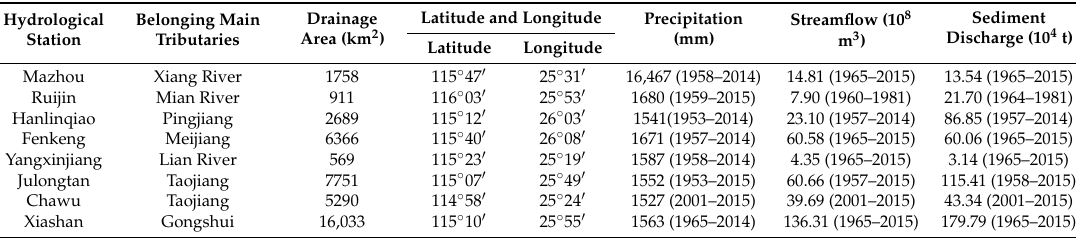
Table 1. Drainage area, average precipitation, annual streamflow, and sediment discharge of the hydrological stations on Gongshui River.